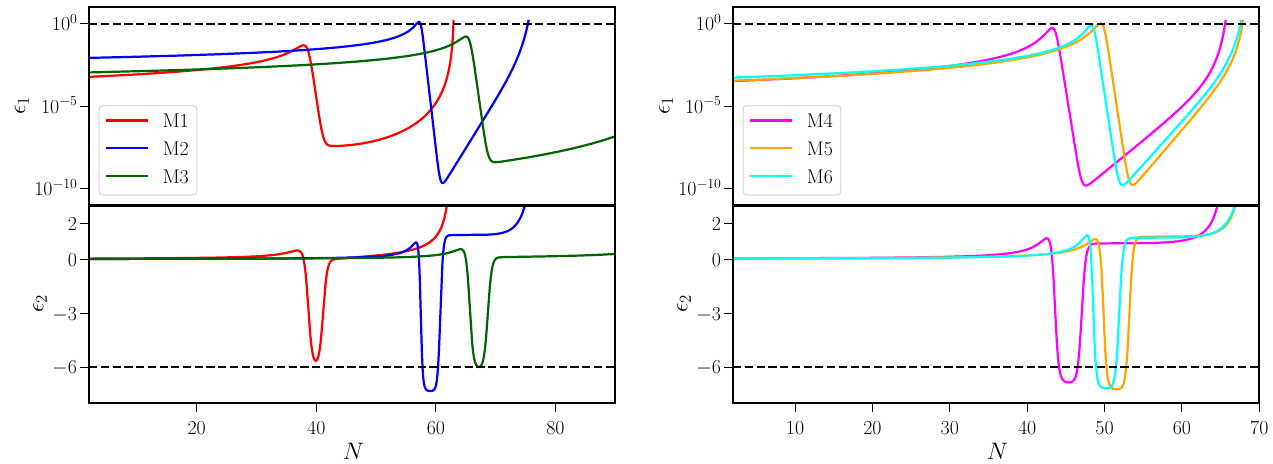
Figure 2. The behavior of the first two slow roll parameters (cid:101) 1 (on top) and (cid:101) 2 (at the bottom) have been plotted for the models M1 to M3 (on the left ) and for M4 to M6 (on the right ). In these plots, we have indicated the values of (cid:101) 1 = 1 and (cid:101) 2 = 6 (in dashed black). We should point out that, when − (cid:101) 1 crosses unity, inflation is either interrupted (provided (cid:101) 1 returns to a value smaller than one soon after) or terminated (if it does not). Note that the value of (cid:101) 2 = 6 corresponds to the case wherein − V φ vanishes identically, a point we have discussed in the